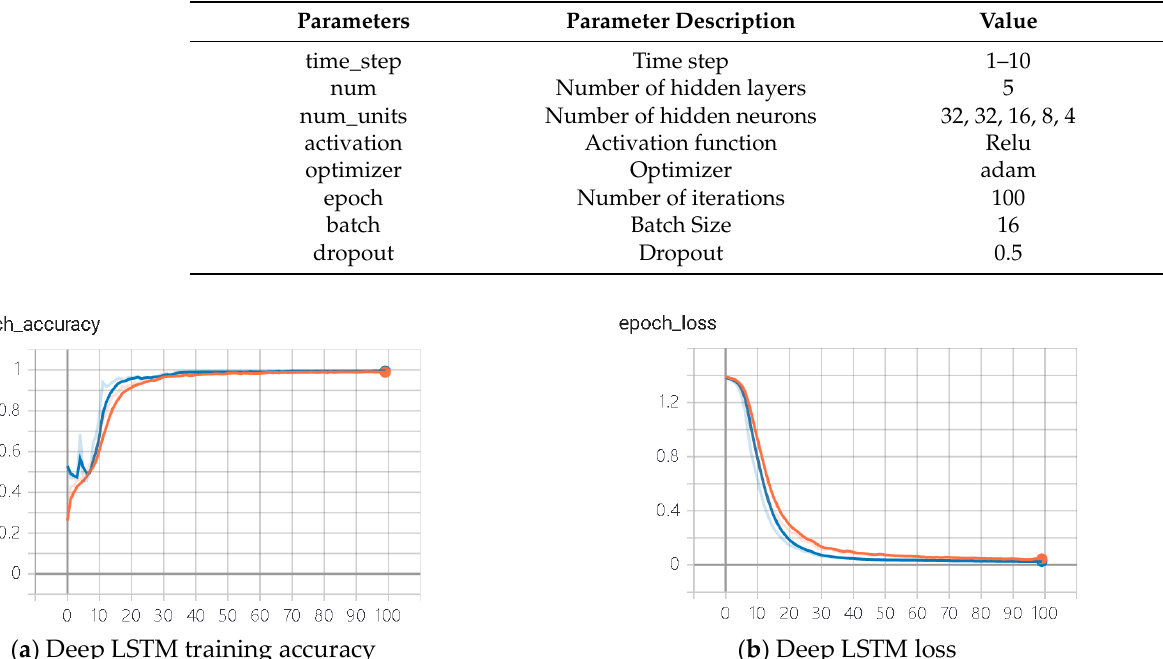
Table 3. The optimal Model hyperparameter setting.